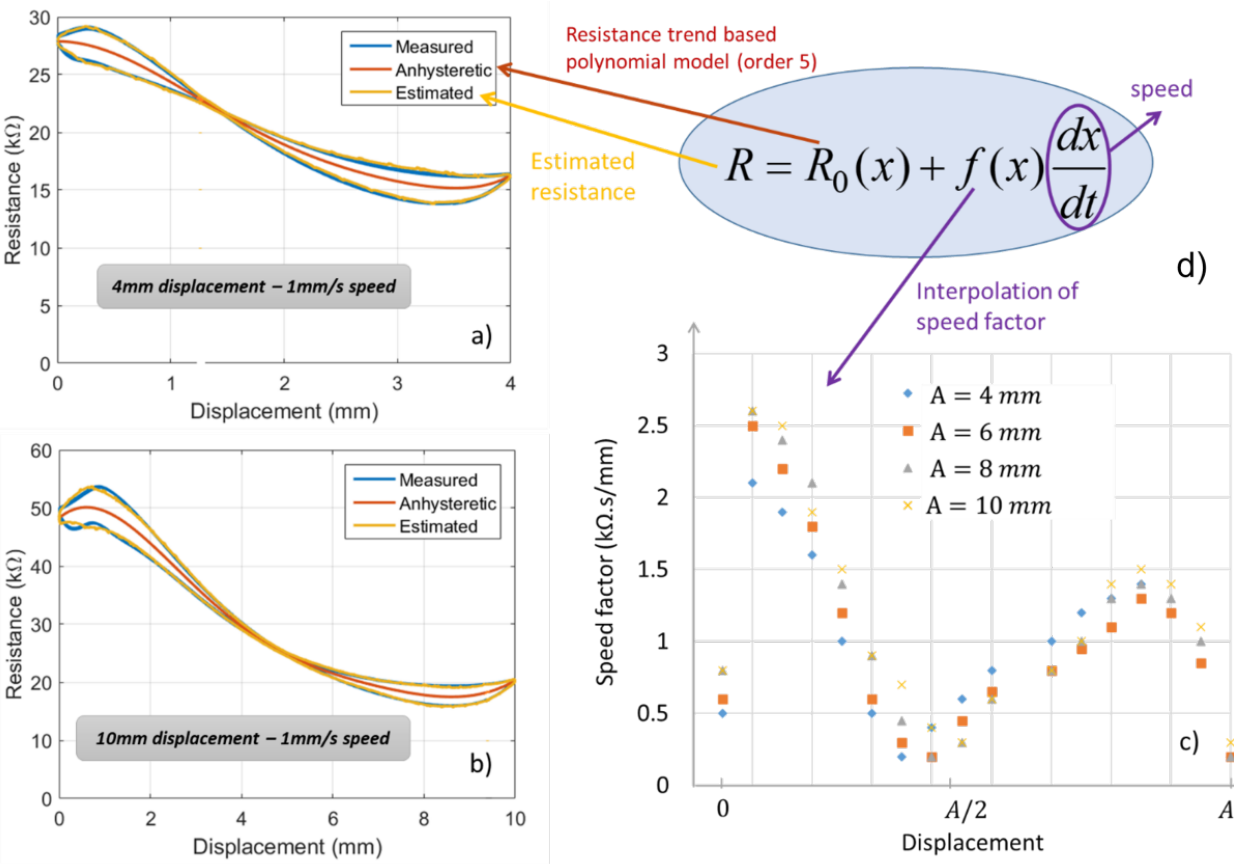
Figure 11. Behavior of the second ink subjected to different mechanical displacements (with speed constant of 1 mm/s): ( a , b ) resistance vs. displacement with amplitude of 4 mm and 10 mm corre- spondingly, ( c ) formula of the estimated resistance, ( d ) interpolation of the speed factor. Unlike the first ink that has positive piezoresistance in which electrical resistance increases proportionally with the increased mechanical strain, the second ink exhibits a neg- ative behavior ( R 0 < 0 ) . Similar results have been reported in the works of Wang et al.